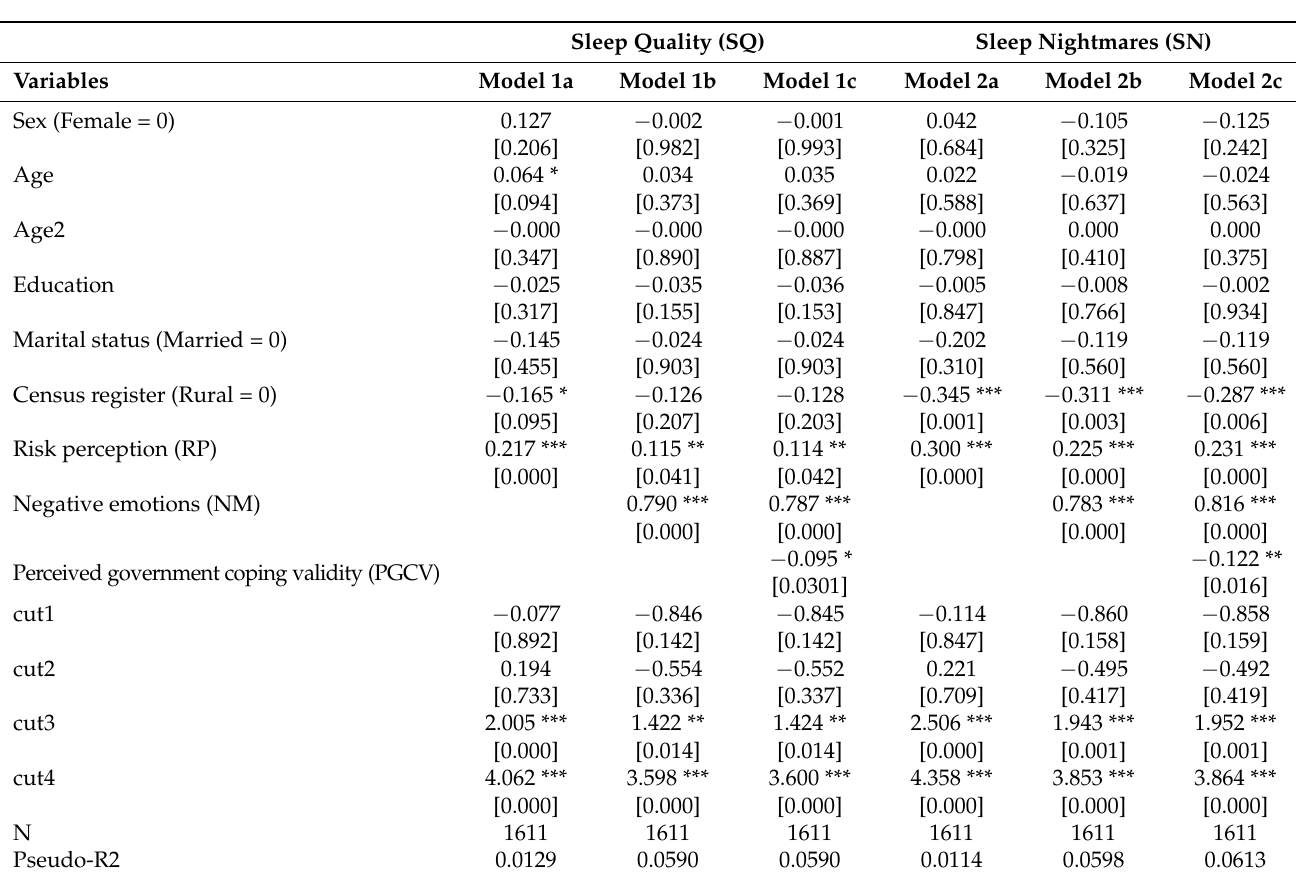
Table 2. Ologit regression model